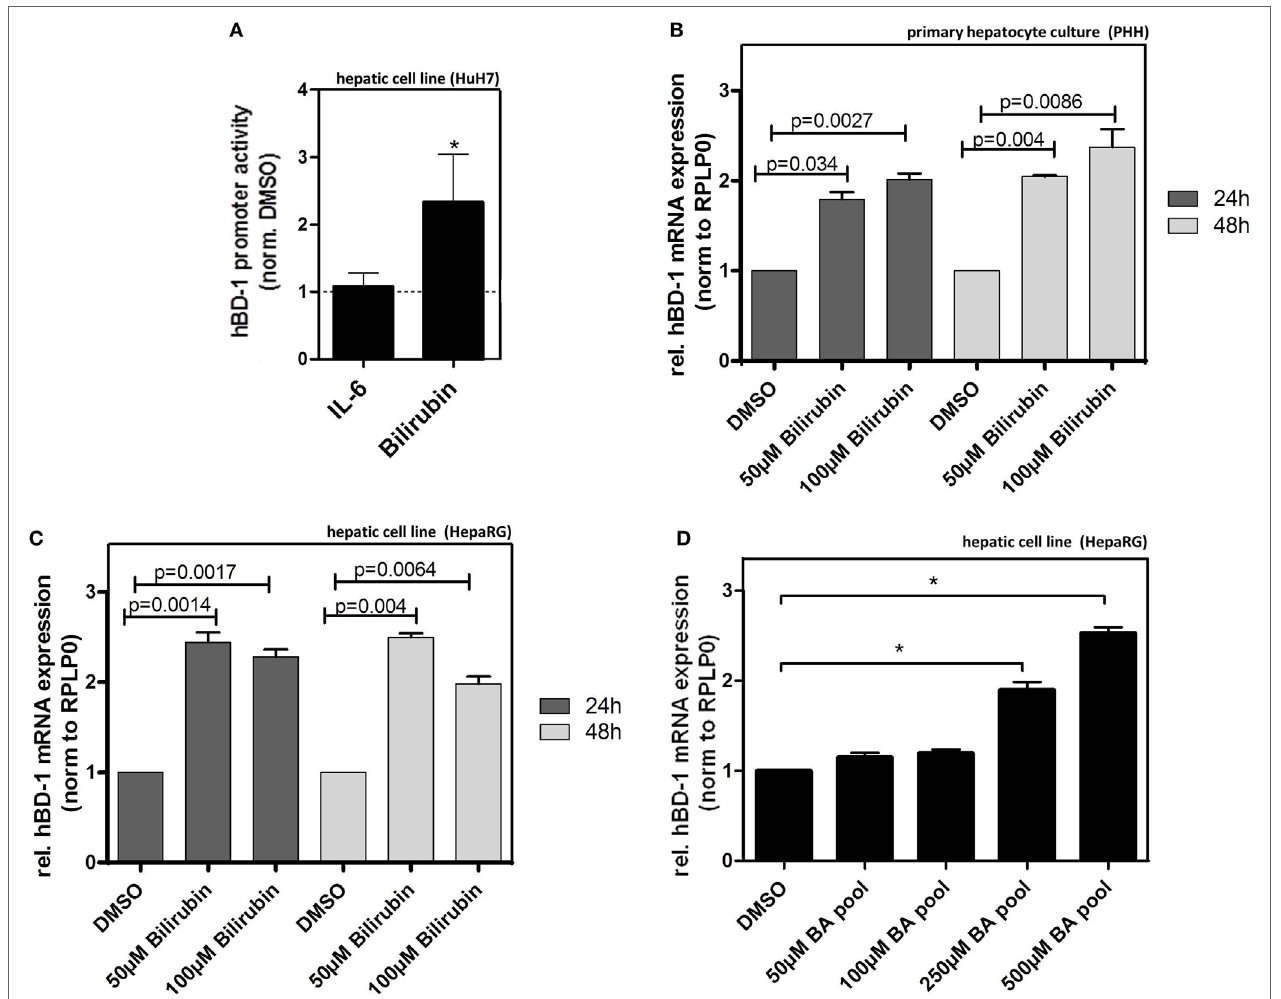
FigUre 5 | Bilirubin and bile acids (BA) induce expression of hBD-1 in hepatic cell lines. (a) Quantitative luciferase reporter gene assays were performed in HuH7 cells 48 h after treatments with 10 ng/ml IL-6 or 100 µM bilirubin in total 72 h after transfection with the luciferase-containing constructs. The cells were co- transfected with the vector containing Renilla luciferase for normalization of transfection efficiency. The bars represent average fold change lucifearse induction normalized to solvent, PBS (for IL-6), or DMSO (for bilirubin), control. Error bars indicate SD between three independent experiments. * p < 0.05. (B) qPCR analysis of hBD-1 expression in three independent batches of primary human hepatocytes, 24 or 48 h following indicated treatment. The bars represent average fold change expression levels normalized to hBD-1 expression in solvent, DMSO, and control. Error bars indicate SD between three independent experiments. (c) Similar to (B) experiments in HepaRG cells performed in two independent HepaRG cultures in two technical replicates. The significance was calculated using data generated in quadriplicates. (D) Treatment of HepaRG cells with different concentrations of BA pool. hBD-1 mRNA expression was assessed 48 h after treatment with the indicated BA concentrations. The bars represent average fold change expression levels normalized to solvent, DMSO, and control. Error bars indicate SD between three independent experiments. * p <